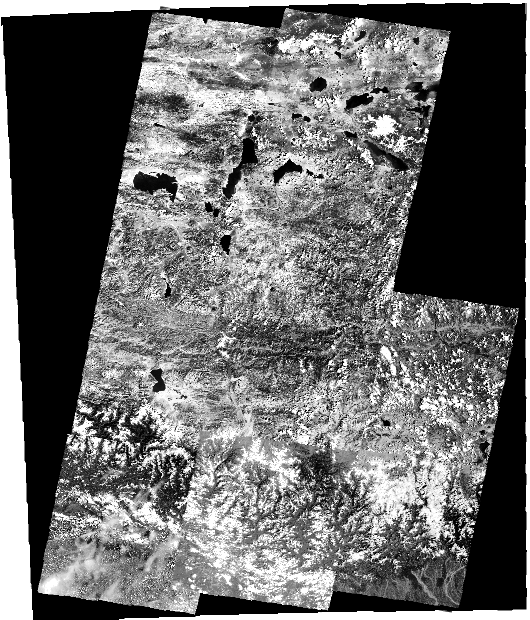
Figure 6. Envi mosaic